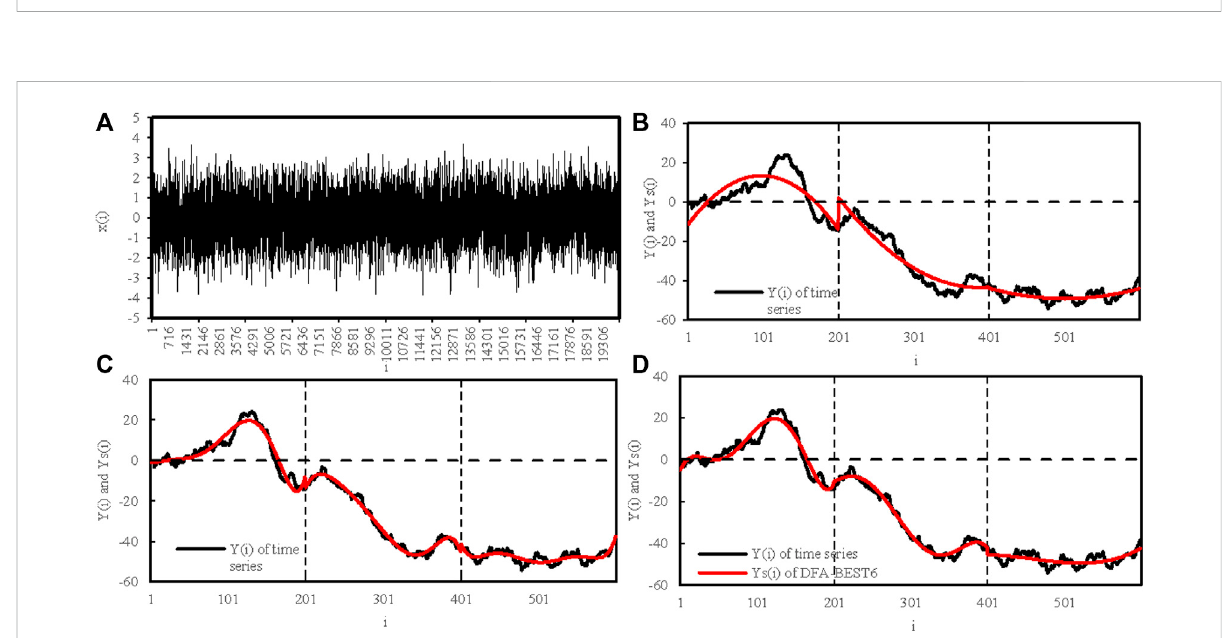
FIGURE 5 (A) timeserieswiththelengthof20,000, andthepro fi lesY(s)(blacklines)andthe fi ttedpro fi lesYs(i)(redlines)calculatedby (B) DFA-2, (C) DFA- 6, and (D) DFA-BEST6 method. The box size s =